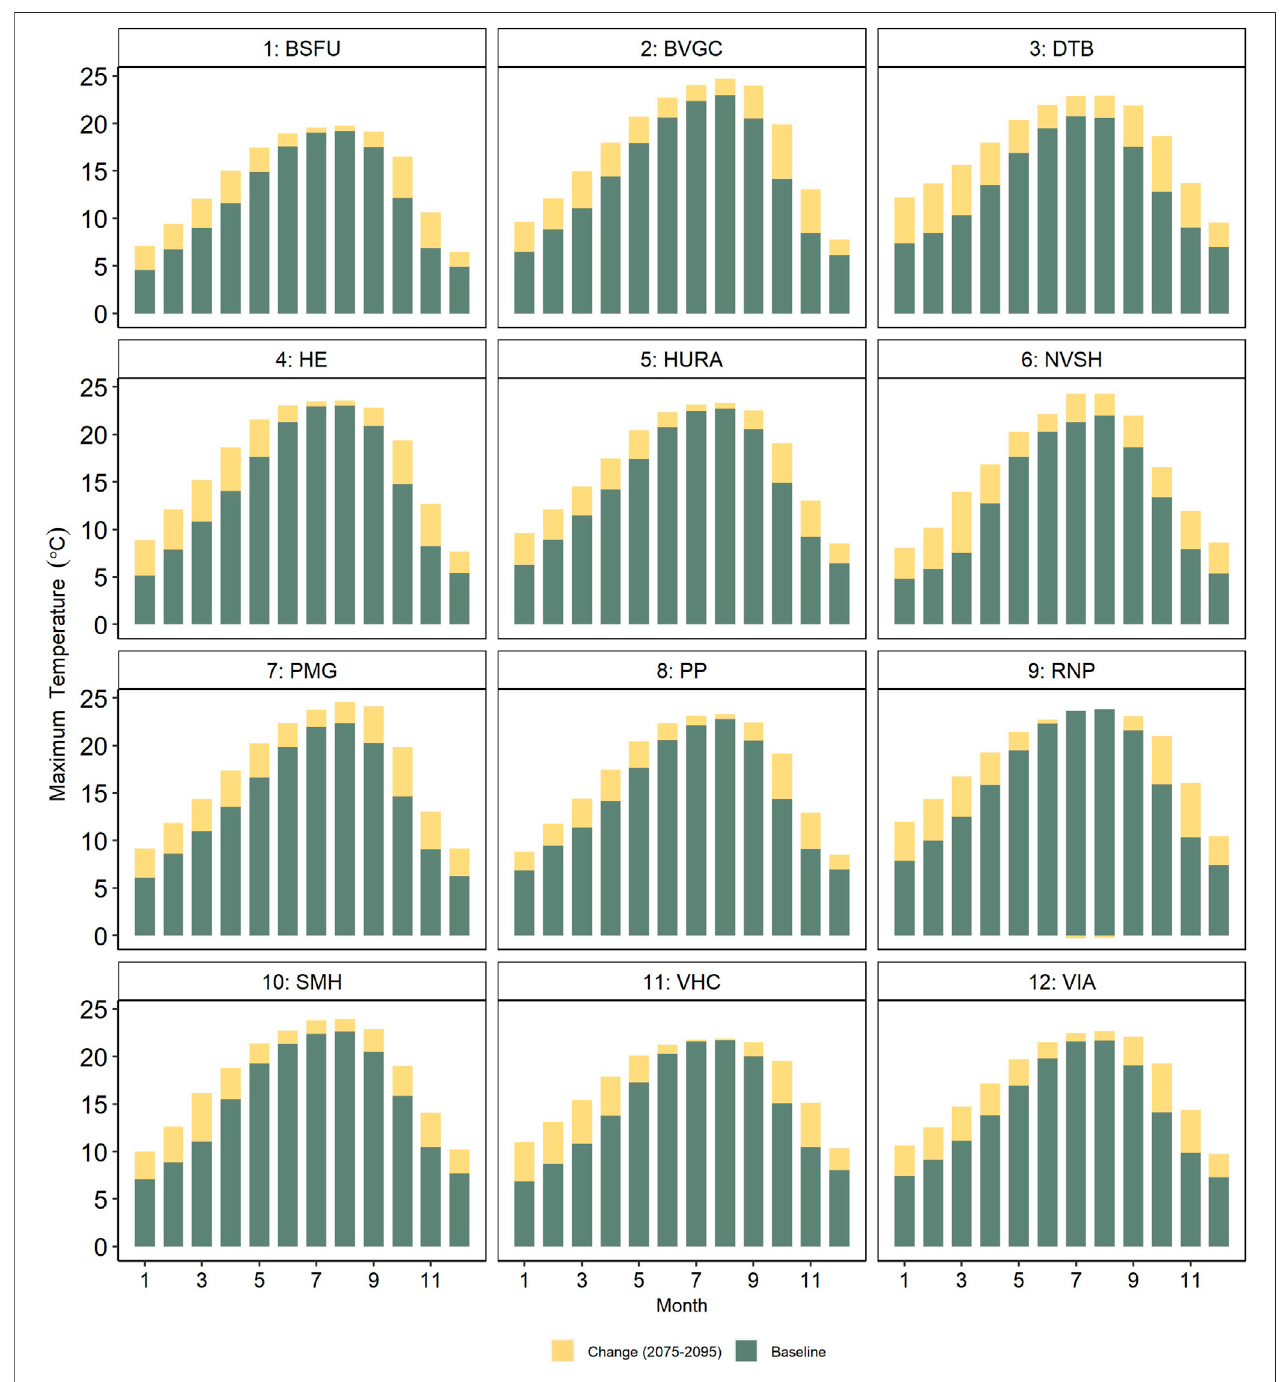
FIGURE 10 | Monthly baseline and projected changes of 2075 – 2095 for maximum